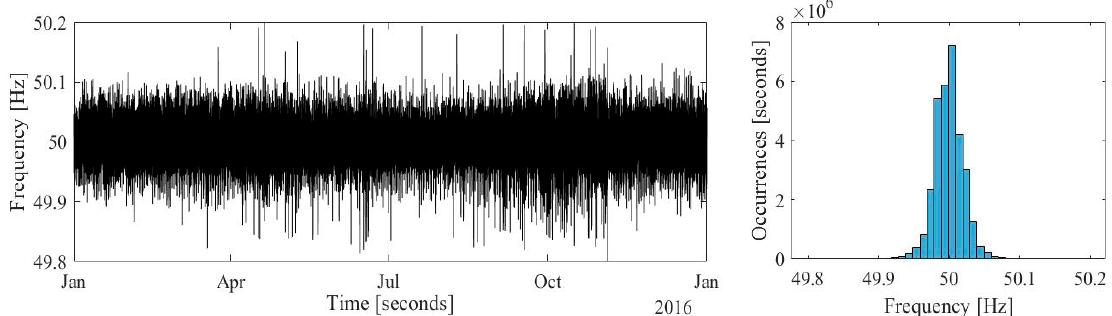
Figure 2. Simplified block diagram of the Simulink tool for the FCR provided by BESS.